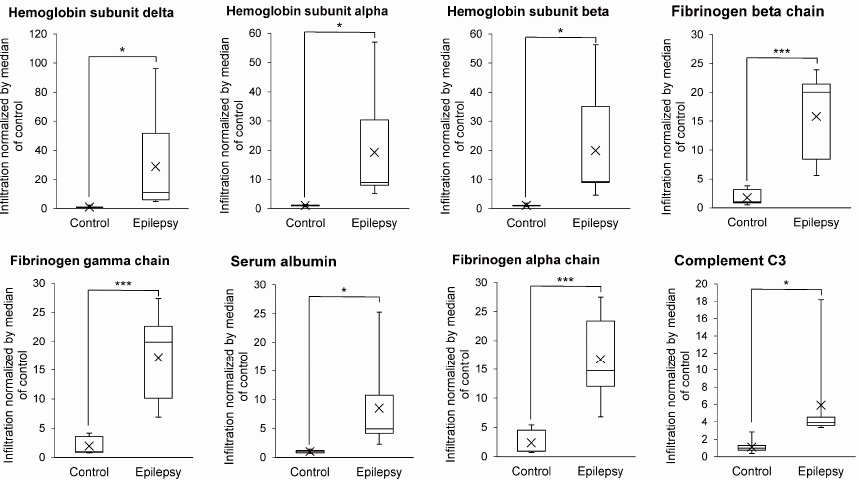
Figure 4. Infiltration of blood proteins in epileptic brain capillaries compared to controls. Brain capillaries were isolated from focal sites in six epilepsy patients and five normal brains; tryptic digests were produced and subjected to SWATH analysis. Blood proteins are defined as the molecules whose tissue specificity in the Uniprot database is classified as ”blood” or “plasma”. Among such molecules, the proteins showing the average ratio (Epilepsy/Control) > 5 and BH-adjusted p value < 0.05 are shown in this table. The band inside the box represents the median, and the bottom and top of the boxes indicate the first and third quartiles, respectively. The whiskers indicate the minimum and maximum values of the protein levels. X plots show the average in each group. The data are normalized by median of the infiltration in control. * BH-adjusted p value < 0.05 and *** BH-adjusted p value < 0.001, significantly different between epilepsy and control groups.